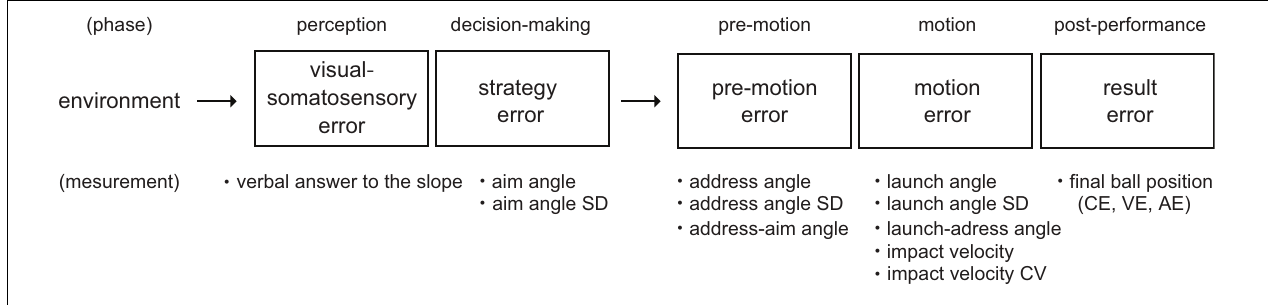
FIGURE 2 | Schematic diagram showing the definition of errors in each phase and the study measurements. The golf putting activity was divided into five phases. The error definition and measurement variables in each phase are shown.